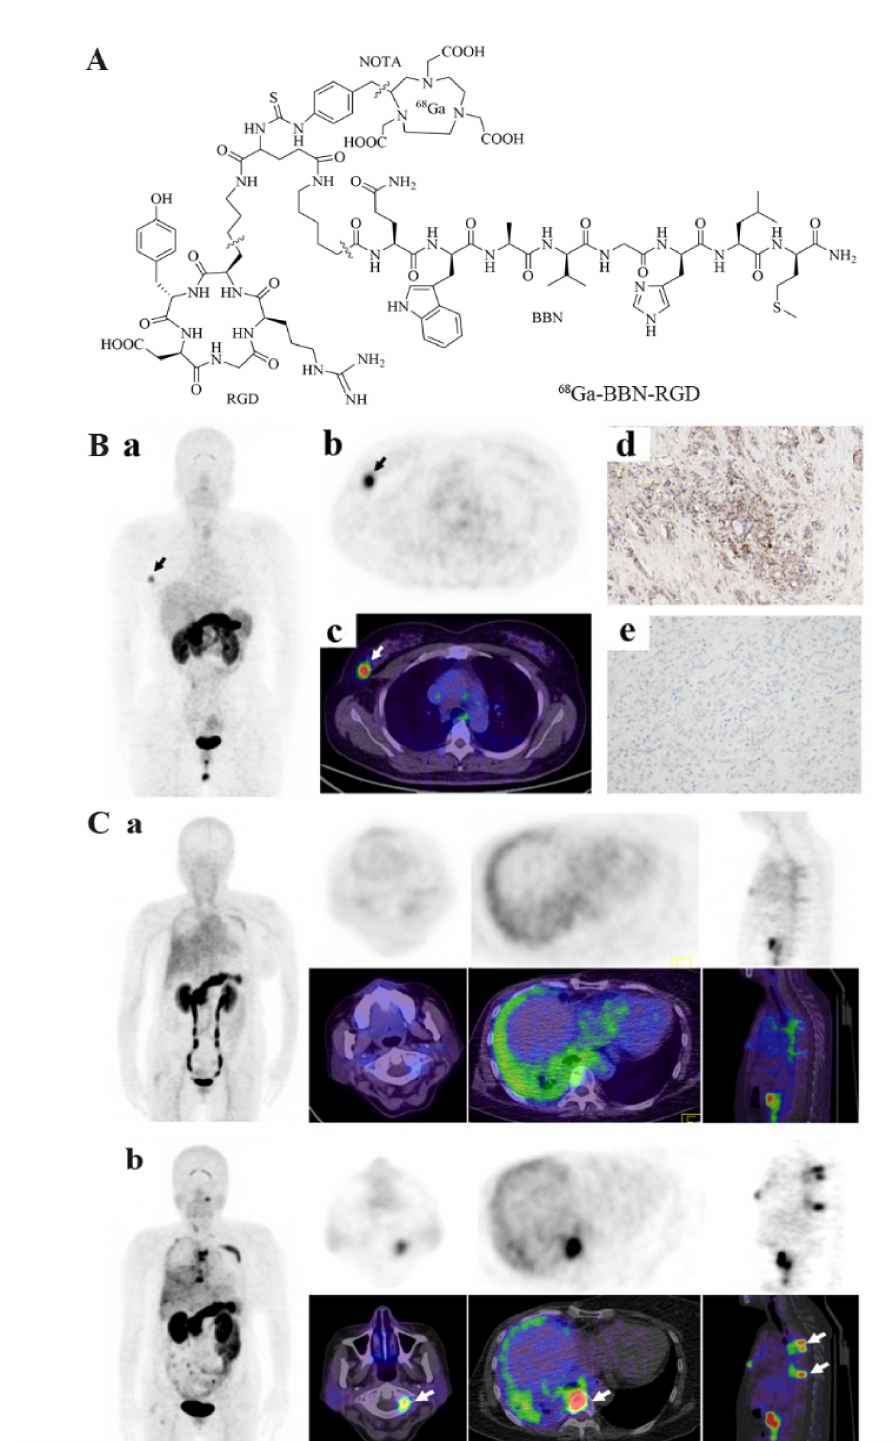
Figure 9. ( A ) chemical structure of 68 Ga-BBN-RGD. ( B ) 68 Ga-BBN-RGD PET/CT in patient with invasive ductal carcinoma ( a – c ). The lesion had a strong GRPR expression ( d ) and weak integrin α v β 3 expression ( e ). ( C ) A 57-year-old woman who underwent breast cancer radical mastectomy and follow-up with 68 Ga-BBN ( a ) and 68 Ga-BBN-RGD ( b ) PET/CT, respectively. 68 Ga-BBN-RGD PET/CT had a significantly higher SUVmax in tumor lesions than that of 68 Ga-BBN PET/CT